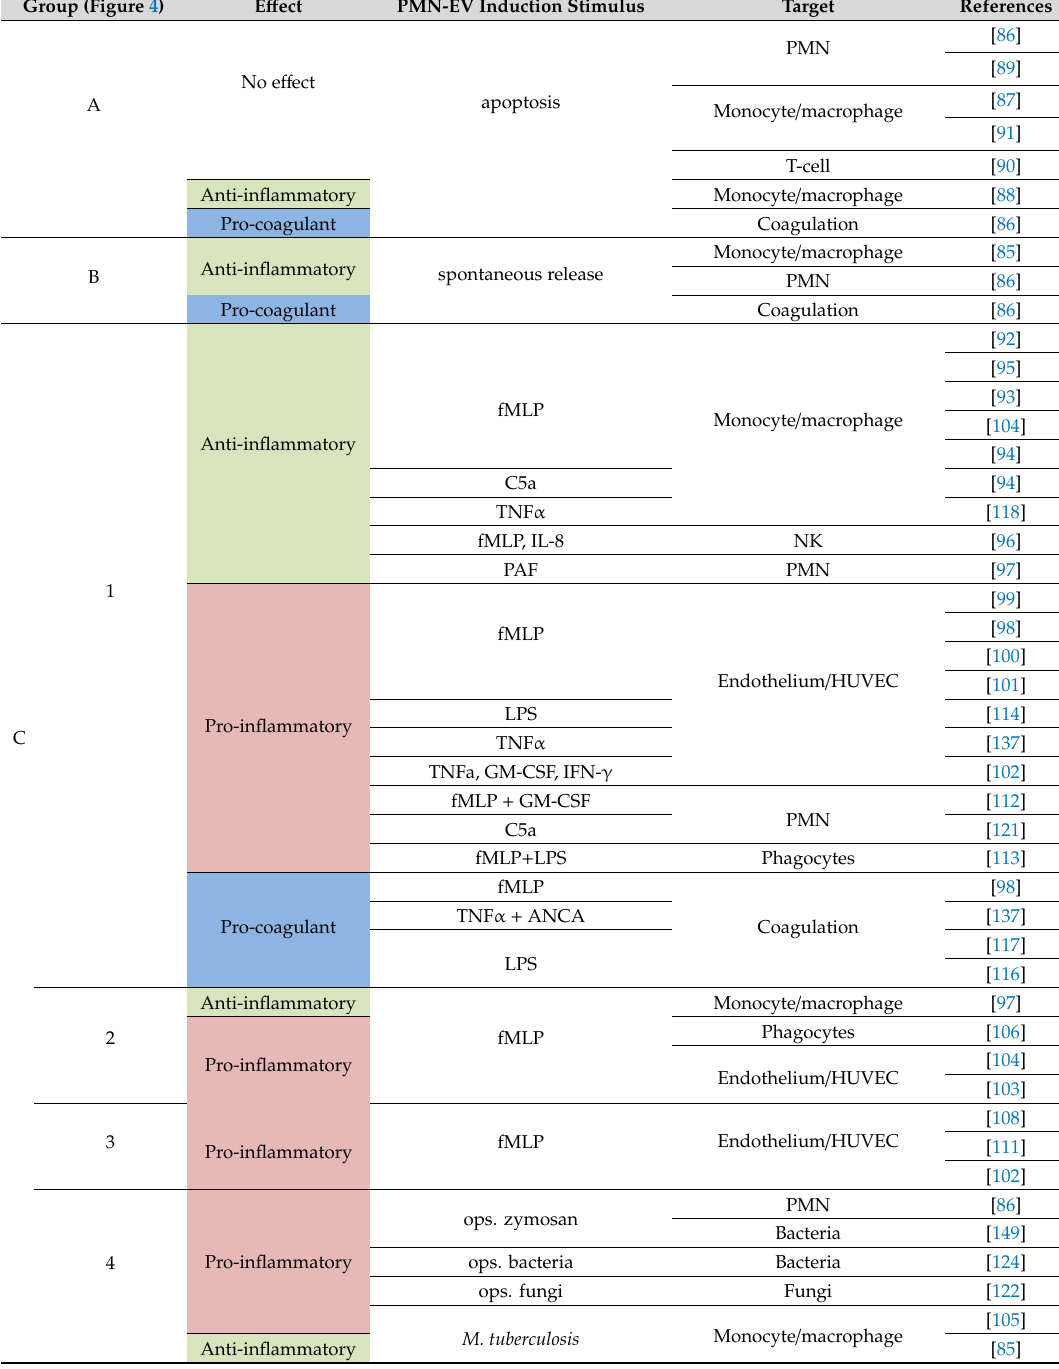
Table 2. List of publications behind Figure 4 and impact of PMN-EVs on target